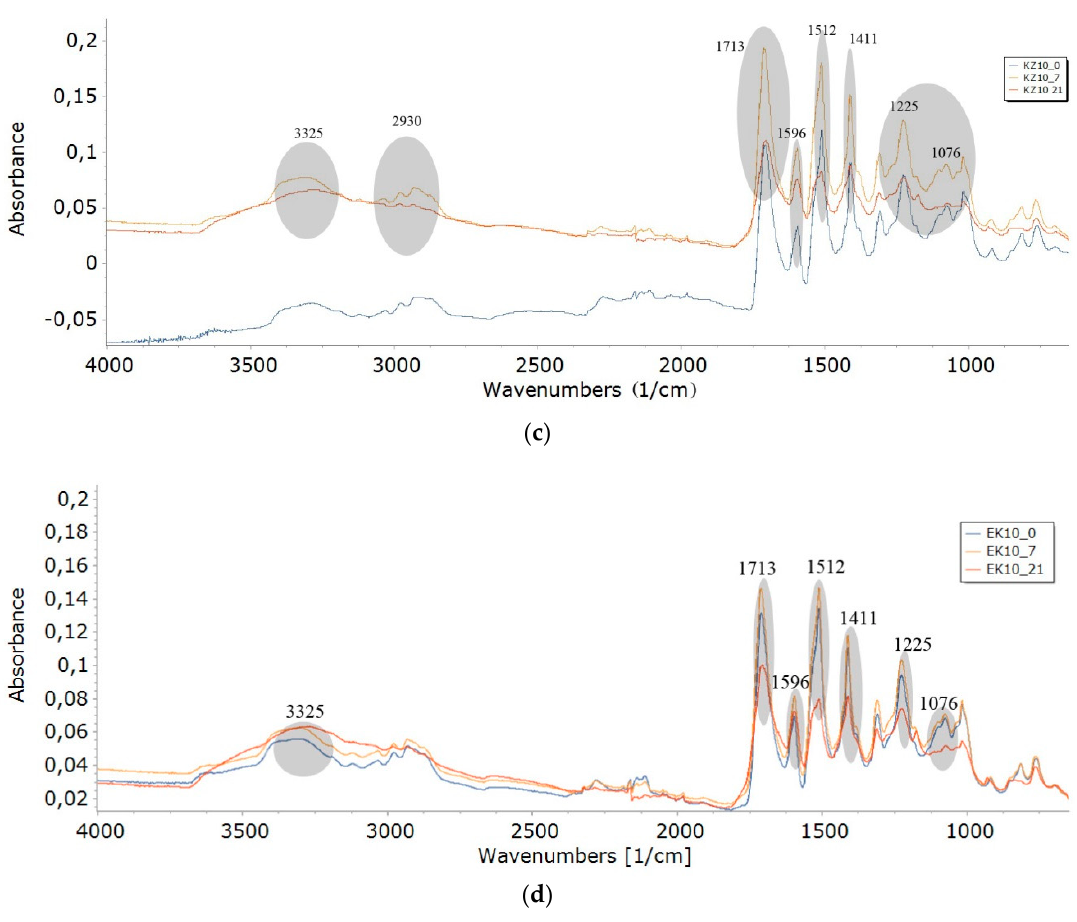
Figure 4. FTIR spectra of: ( a ) W series; ( b ) C series; ( c ) KZ series; and ( d ) EK series.